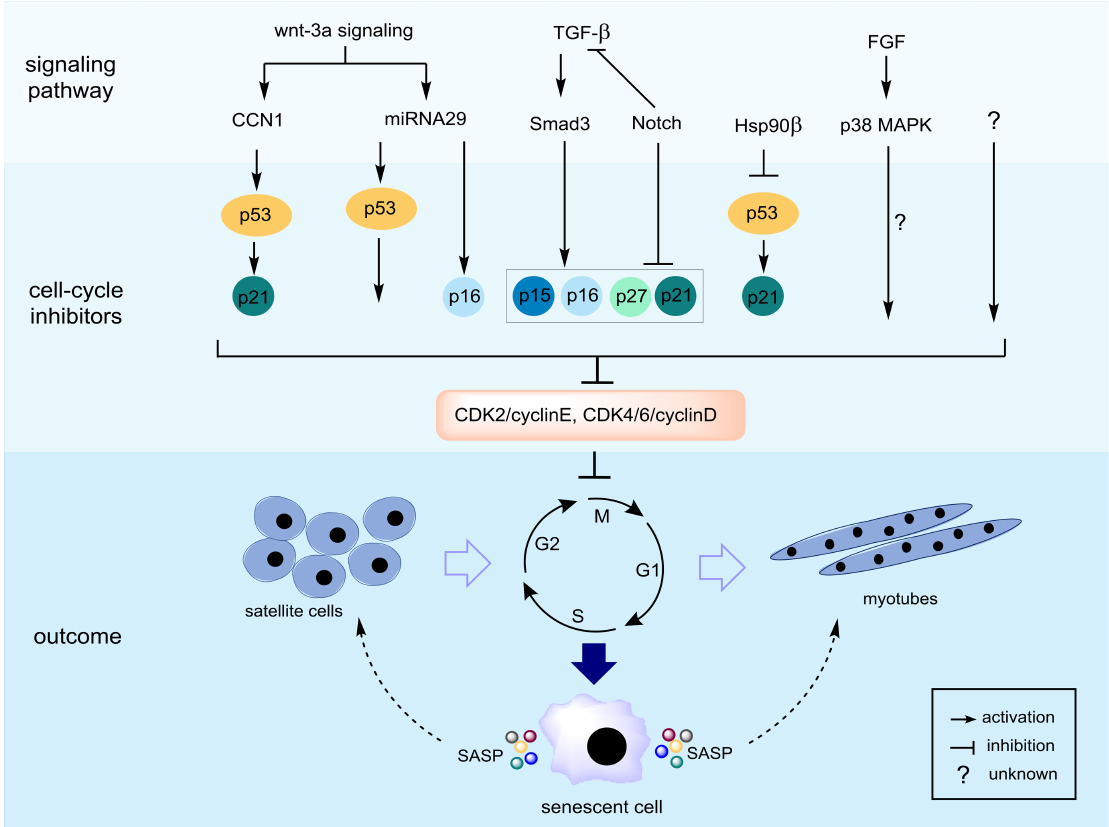
Figure 2. Possible molecular mechanisms of cellular senescence in skeletal muscle cells. The cell-cycle exit is mainly regulated by induction of cyclin-dependent kinase (CDK) inhibitors including p53–p21 Cip , p16 Ink4a / p15 Ink4b , andp27 Kip1 . CCN1andmiRNA29directlyactivatebothp53andp21 Cip , whileHsp90 β represses p53–p21 Cip signaling. Transforming growth factor (TGF)- β signaling activates CDK